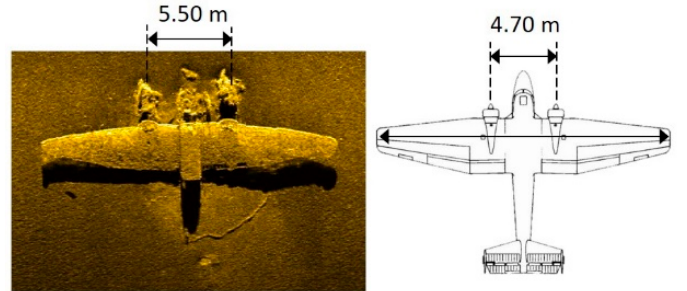
Figure 13. Comparison of the distance between the wing-mounted engines based on sonar data and technical data of the Szcze-2 aircraft.